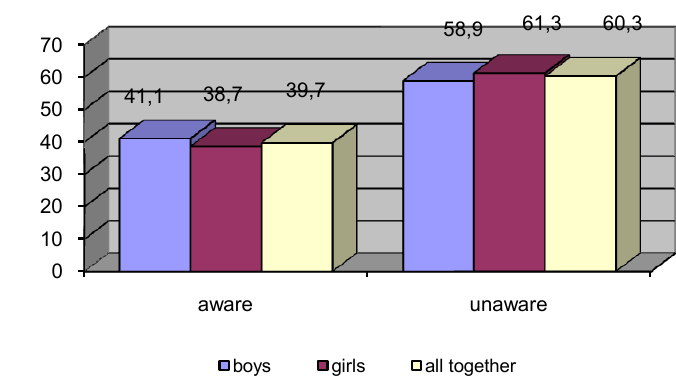
Fig. 3. Schoolchildren’s awareness of the subject of the Olympic slogan